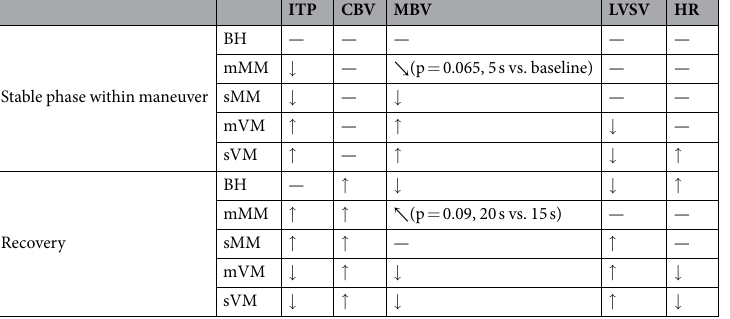
within the strain and in the recovery phase of 5 graded respiratory maneuvers (RMs) in the same sub- jects. The changes in intrathoracic pressure (ITP) induced by the RMs are carefully monitored by esopha- geal manometry. We find that despite of the various changes of ITP within the RMs, CBV is stable compared to its baseline but MBV changes in the same direction as ITP. Cerebral StO 2 only decreases within strong